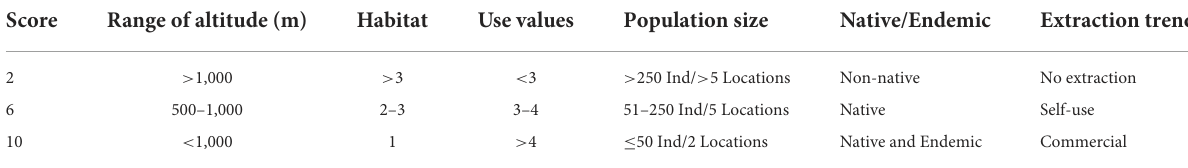
TABLE 1 Attributes used for calculating the CPI of plant species in GWLS.